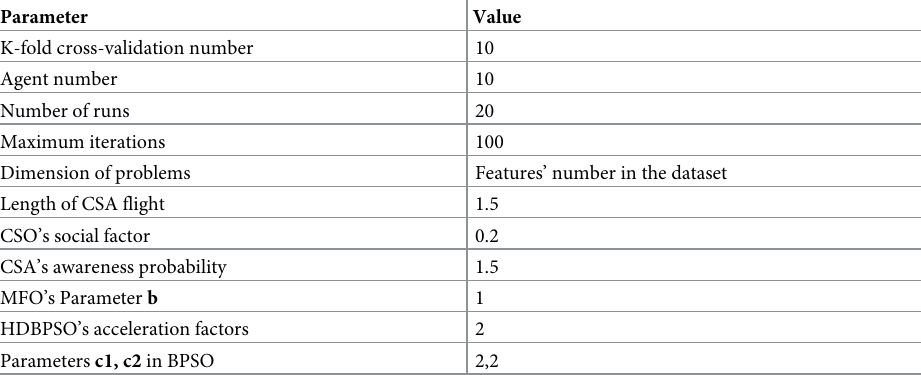
Table 2. Experiment’s parameter